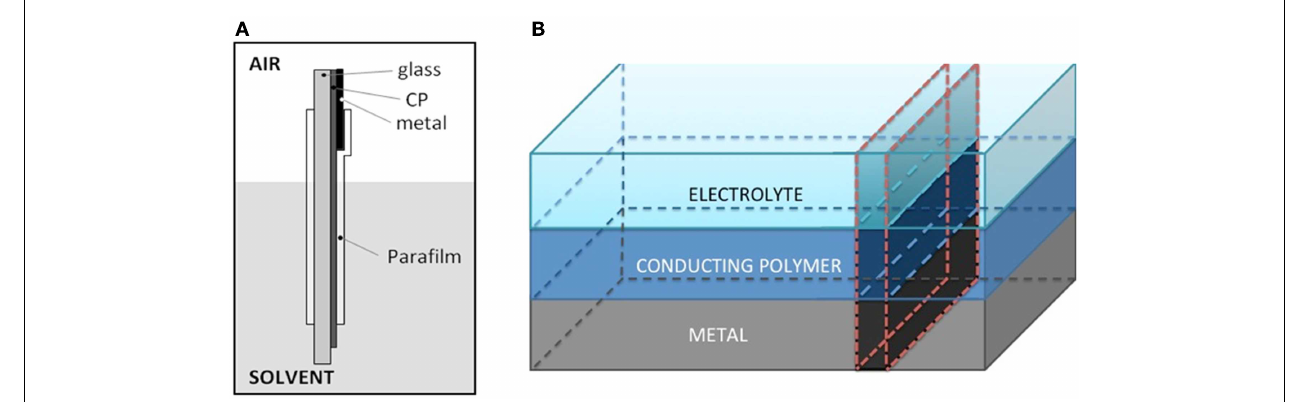
two Parafilm® layers under strain to prevent the direct electrolyte contact. Around 1mm of the CP remains uncoated at the bottom allowing there the direct CP/electrolyte contact. (B) The new design mimics a transversal cut of a conducting polymer (CP) film: